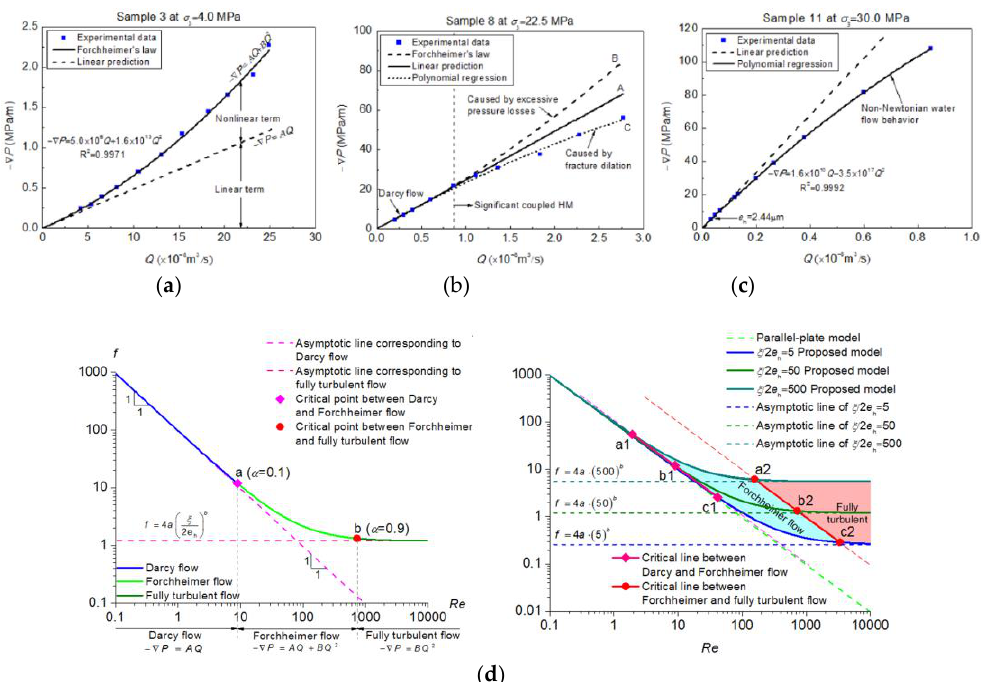
Figure 6. Experimental outcomes of solute migration and viscous fingering along a transparent rough fracture [52–56]: ( a ) Solute migration test and breakthrough curve; ( b ) developing process of viscous fingering.